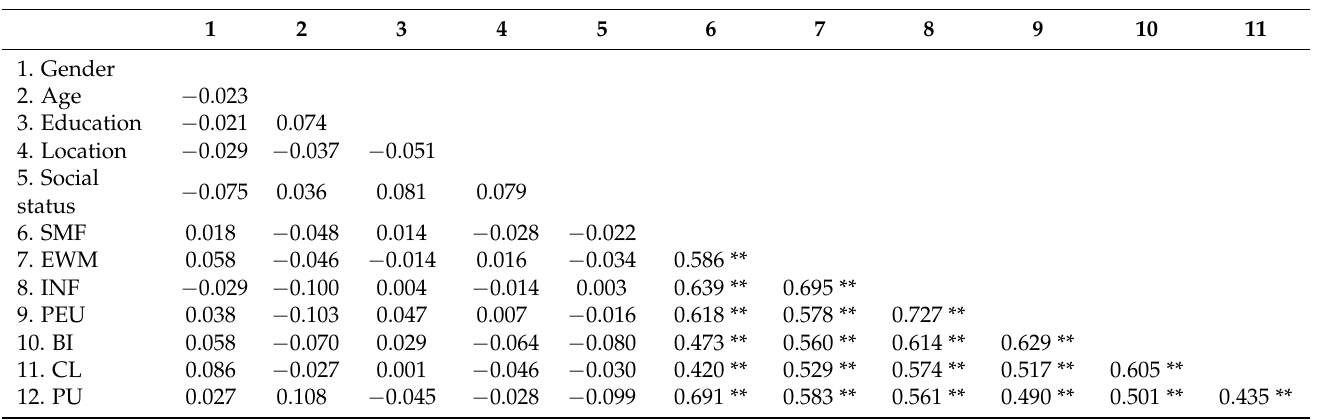
Table 1. The results of correlations between variables.